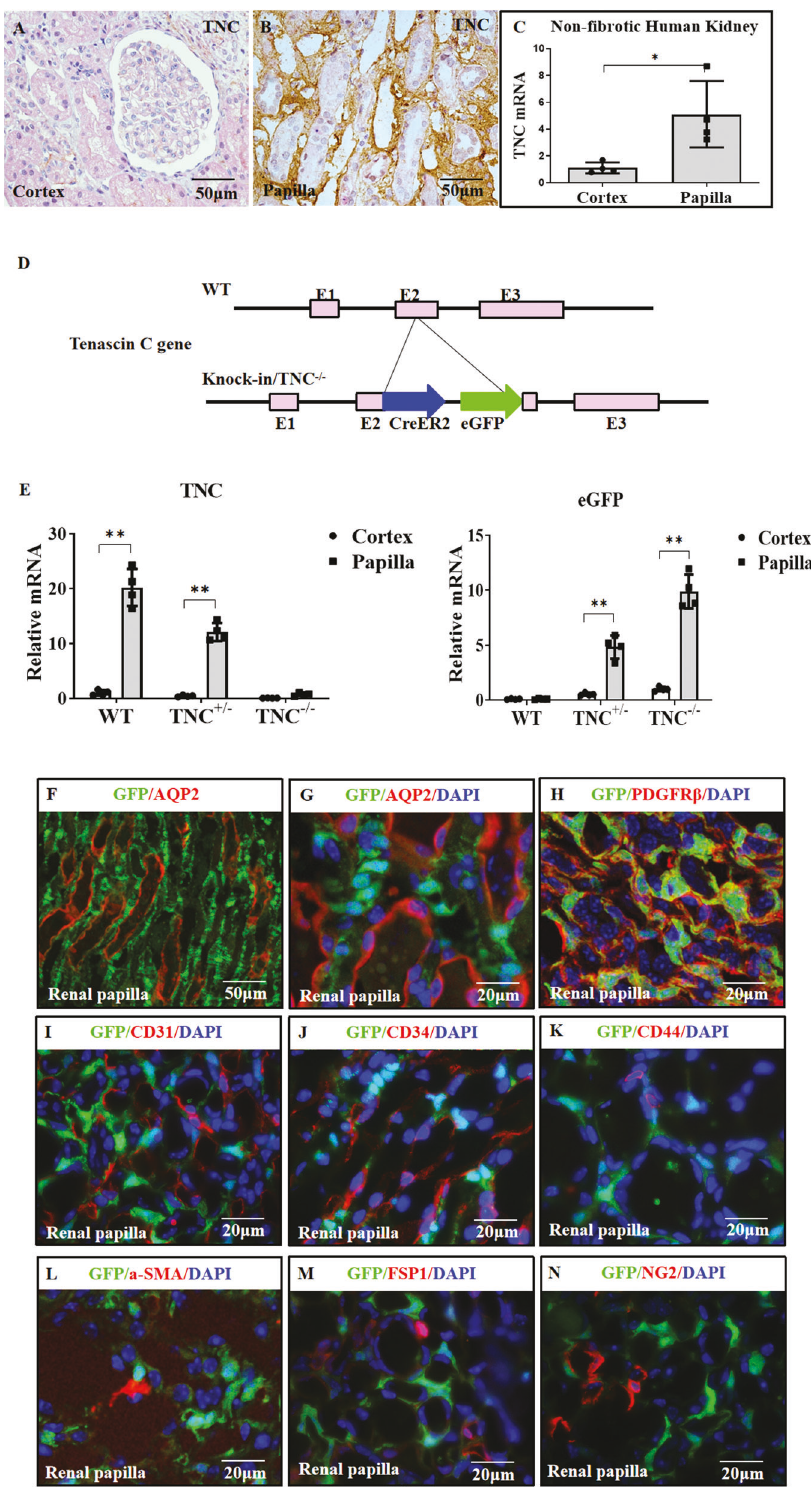
Fig. 1 TNC was constitutively expressed by renal medullary stromal cells in normal kidney. In normal human kidney (kidneys resected because of renal carcinoma), TNC was rarely detected in the cortex, but rich in the medullary interstitium ( A , B , n = 4, 4 sections for each). Quantitative PCR also showed TNC mRNA was signi fi cantly higher in non- fi brotic renal papilla than in cortex ( C , n = 4, p = 0.019). To explore the role of TNC, a TNC-promoter-driven inducible CreER2 knock-in mouse line with an eGFP reporter was generated, and the insertion of CreER2- eGFP lead to TNC deletion ( D ). Messenger RNA of TNC and TNC reporter eGFP was signi fi cantly higher in the renal papilla than in the renal cortex ( E , n = 4 for each, p < 0.01). Co-staining for eGFP and AQP2 showed that eGFP-positive cells were located in the renal medullary interstitium ( F , G ). These eGFP-positive cells were PDGFR β positive, consistent with stromal cells ( H ), but negative for CD31 (a marker of endothelial cells, I ), CD34 (a marker of endothelial cells and early hematopoietic stem cells and progenitors, J ) and CD44 (a marker of progenitors, K ). They were also negative for α SMA (a marker of myo fi broblasts, L ), FSP1 (a marker of fi broblasts, M ) and NG2 (a marker of pericytes, N ). ( n = 4, 3 slides for each). Cell Death and Disease (2022)